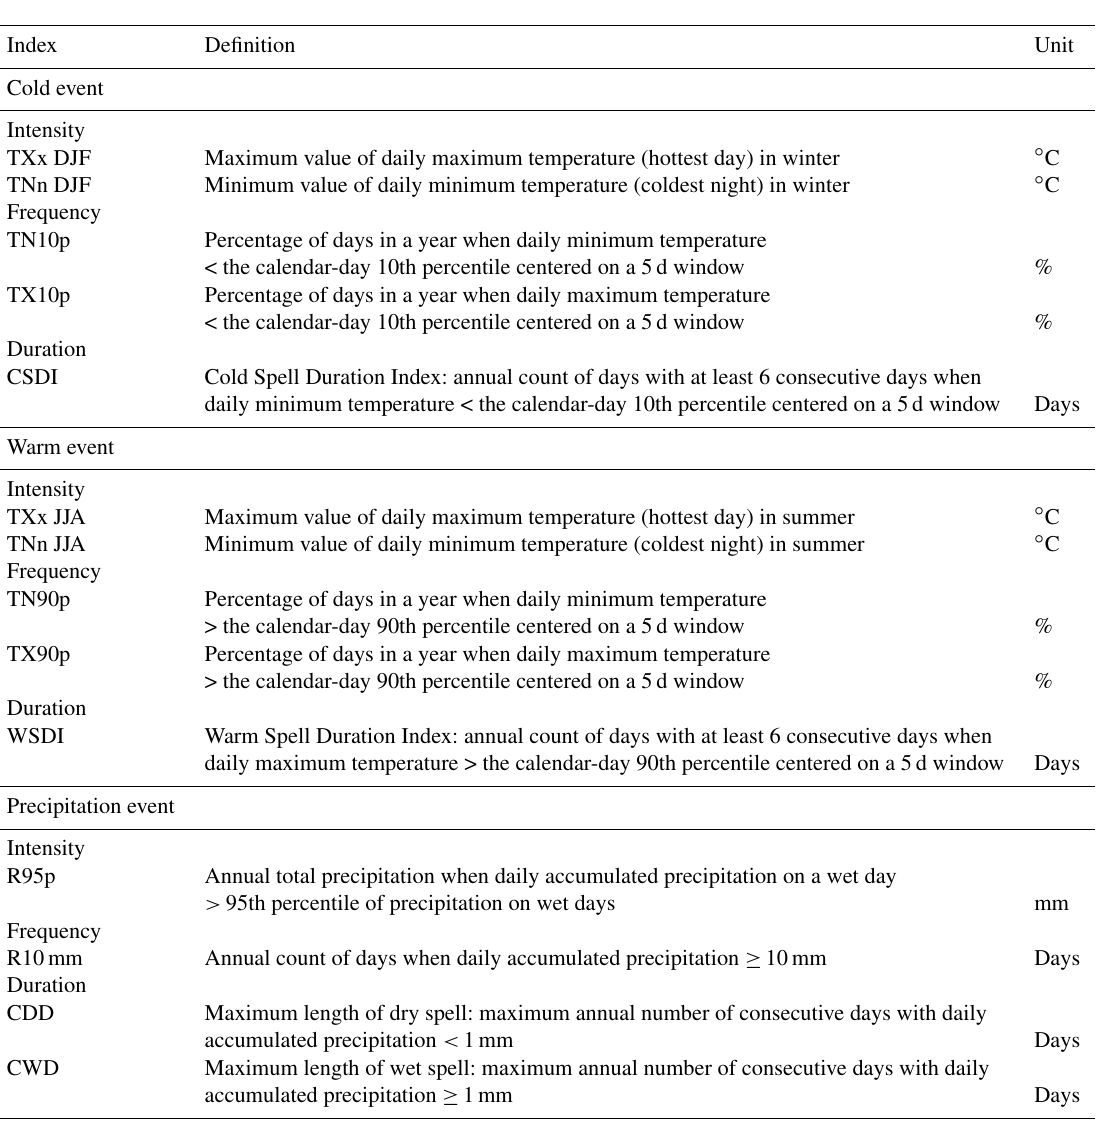
Table 2. List of extreme indices used in this study defined by the Expert Team on Climate Change Detection and Indices (ETCCDI) (Karl et al., 1999). Percentiles are calculated over the period 1980–2000.